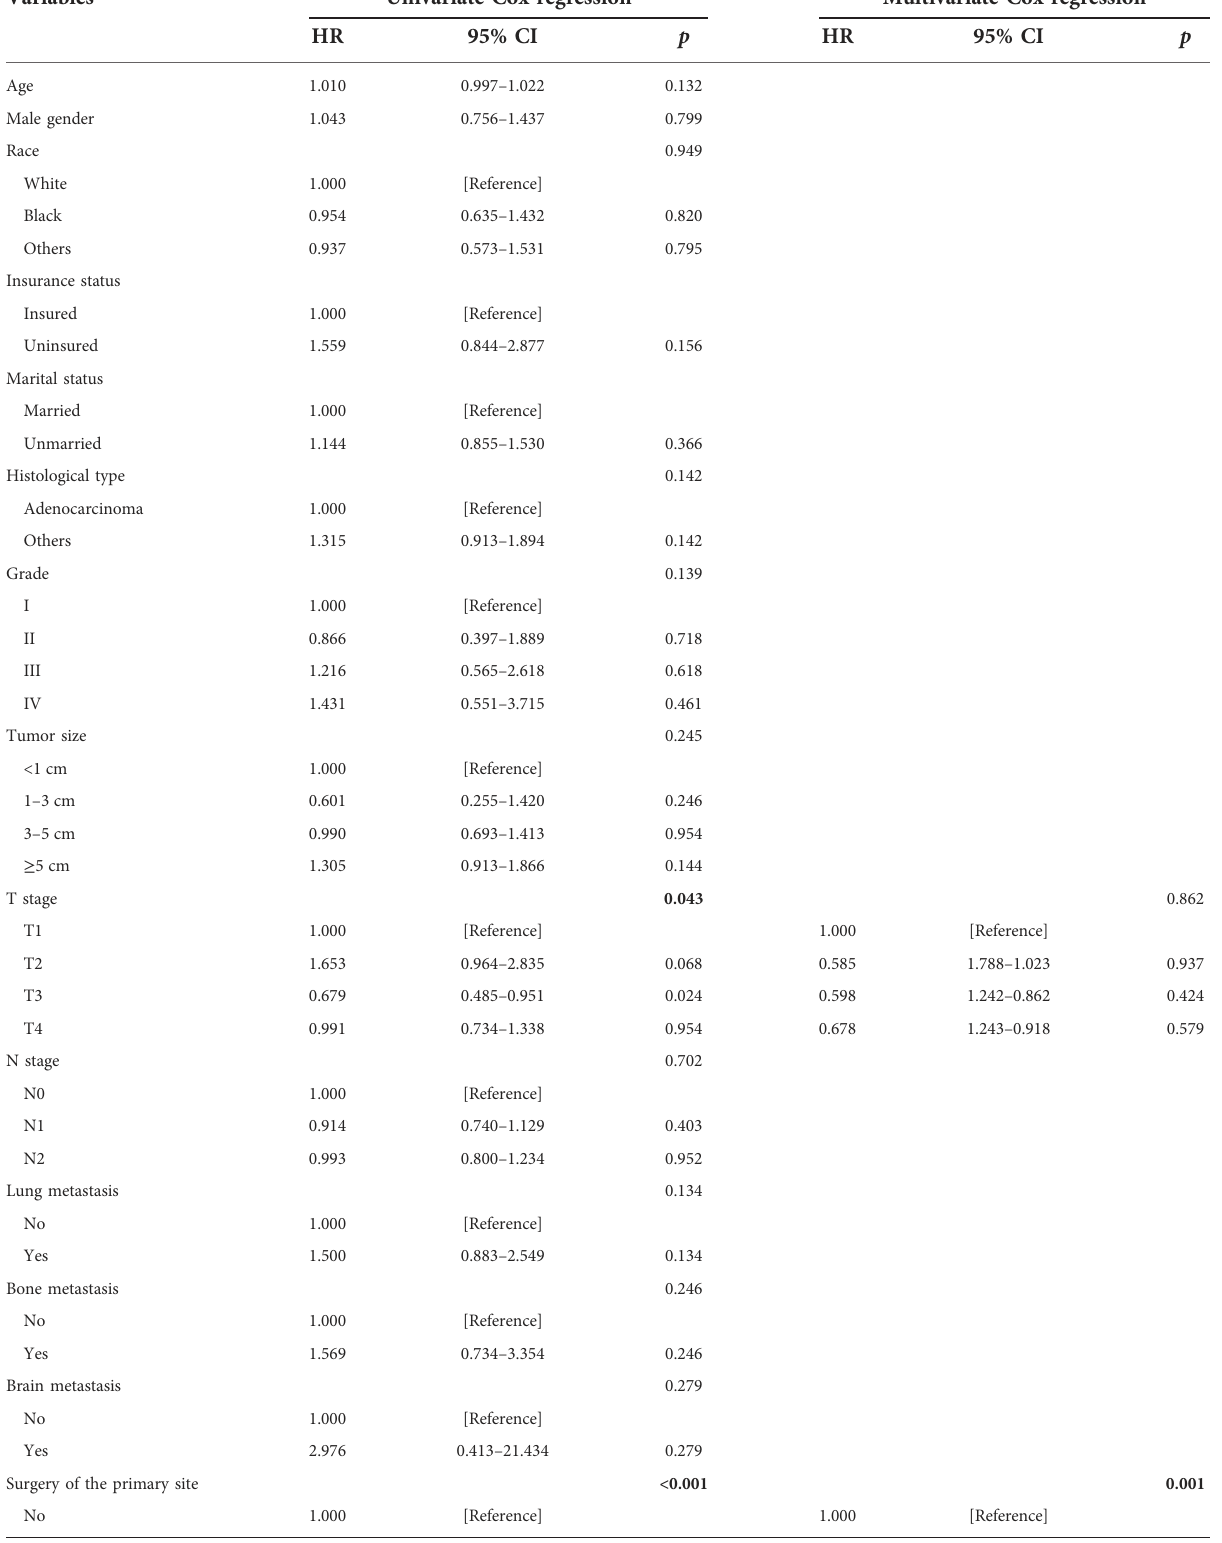
TABLE 4 Risk factors for prognosis of gallbladder cancer patients with liver metastasis analyzed by Cox